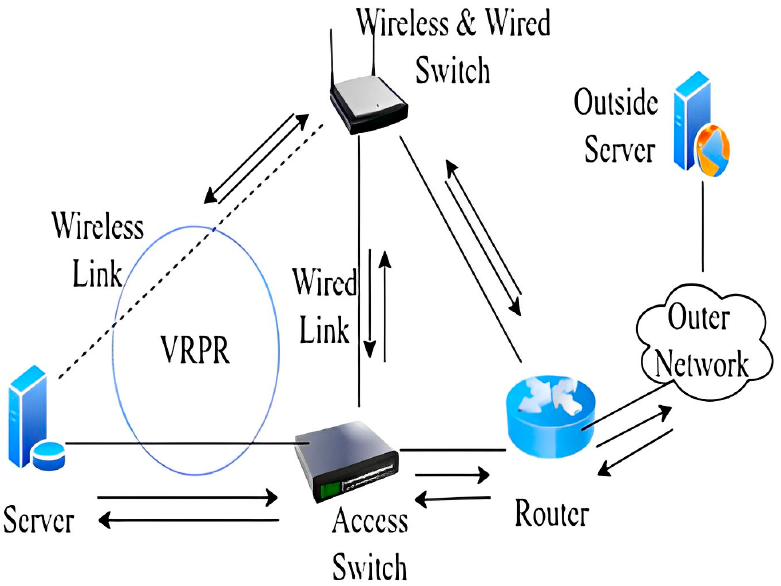
Figure 5. Traffic flow diagram of VRPR-based network model.